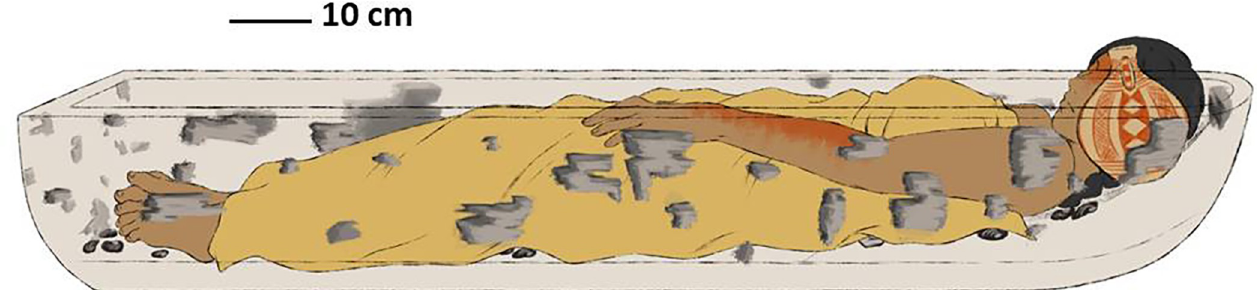
PLOS ONE | https://doi.org/10.1371/journal.pone.0272833 August 24,